Question: Looking at the figure, what chart type is it?
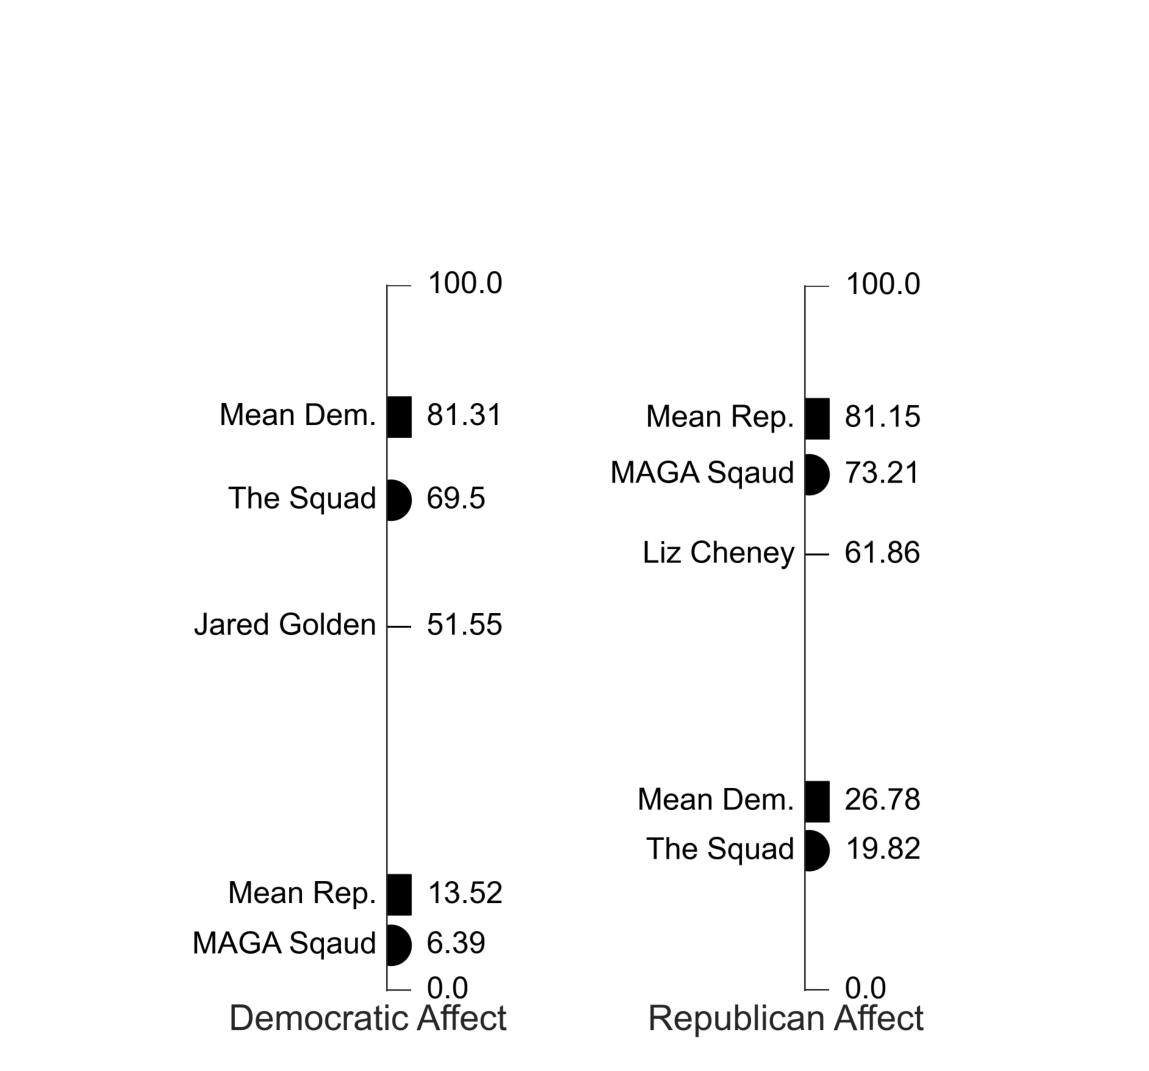
Answer: line